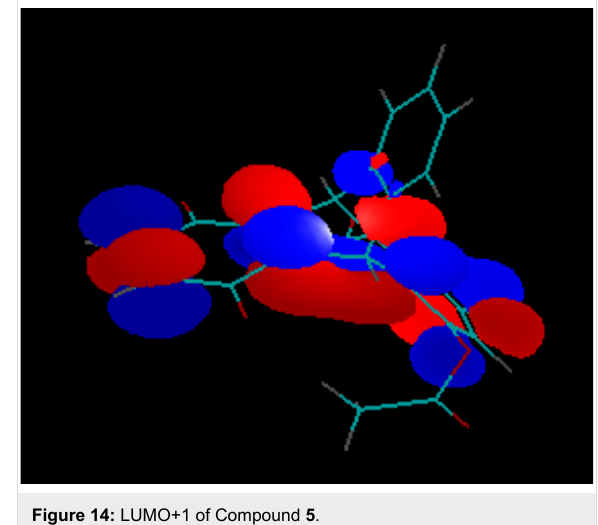
activate the leaving acetoxy-anions, keeping the product of one- electron reduction stable (Figure 13). The second electron placed on the LUMO+1 orbital of 5 , activates the acetoxy- groups, which causes decomposition of the product of the two electron reduction (Figure 14) and makes the second reduction chemically irreversible.